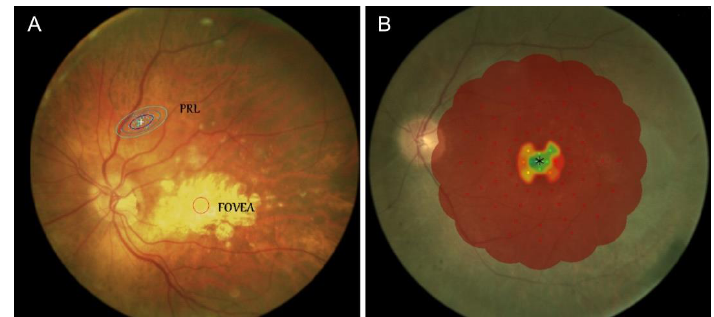
Figure 2. Preferred Retinal Locus (PRL) in visually impaired patients: ( A ) PRL location in patients with central low vision; ( B ) Microperimetric examination (MP-1) of a patient with severe peripheral vision loss. The green central points represent the central-vision area preserved, while the large red